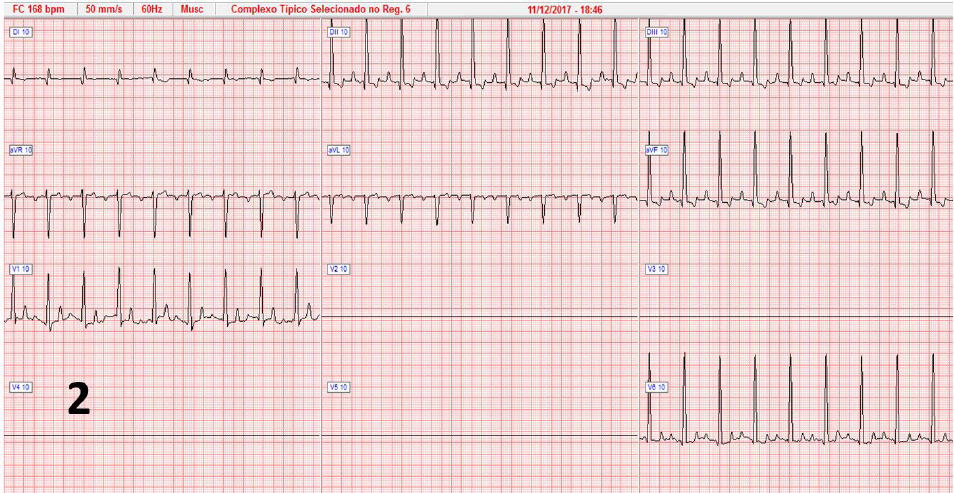
Figure 4. ECG after conversion into normal sinus rhythm. The heart-rate was 160 bpm. The P waves are wide (52 ms), indicative of left atrial enlargement. Paper speed = 50 mm/sec; calibration: 1 cm =